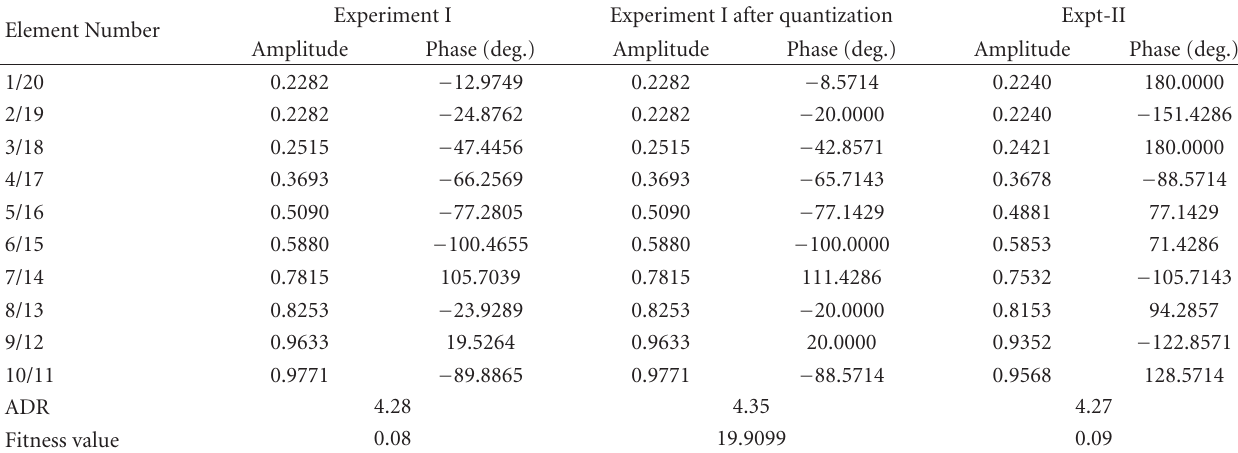
Table 4: Optimum results of Experimental I and Experiment II with ADR.